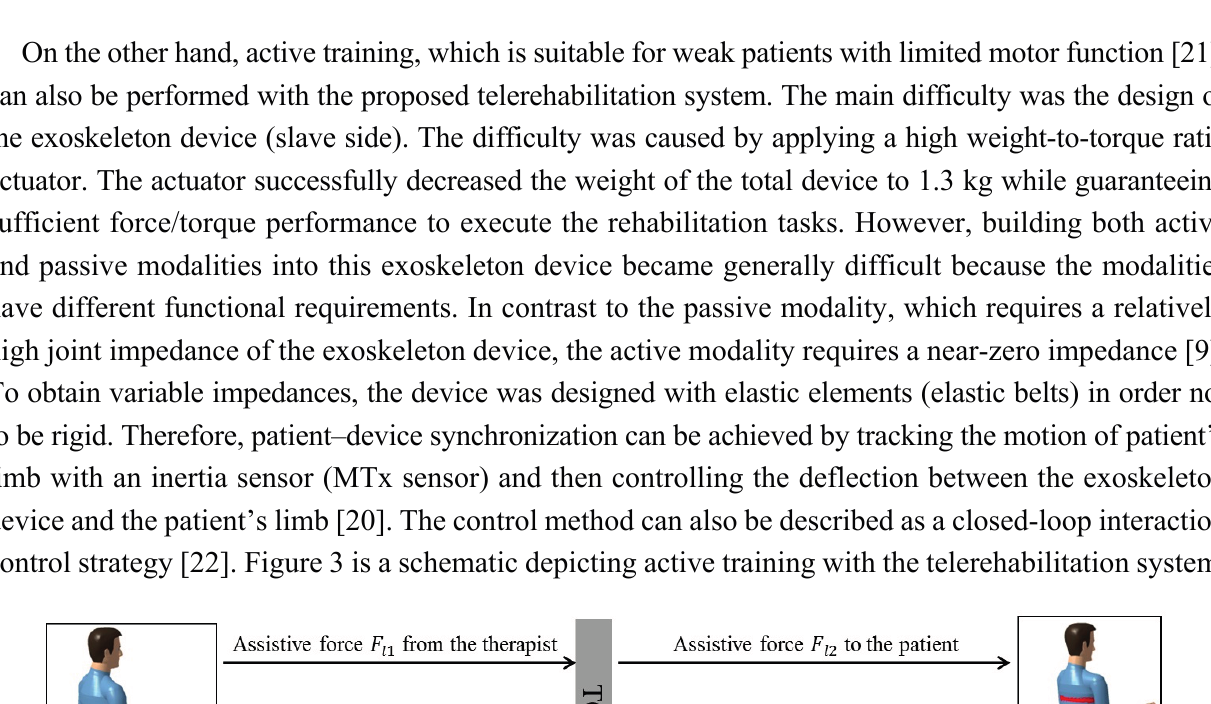
Figure 2. Schematic of passive training.